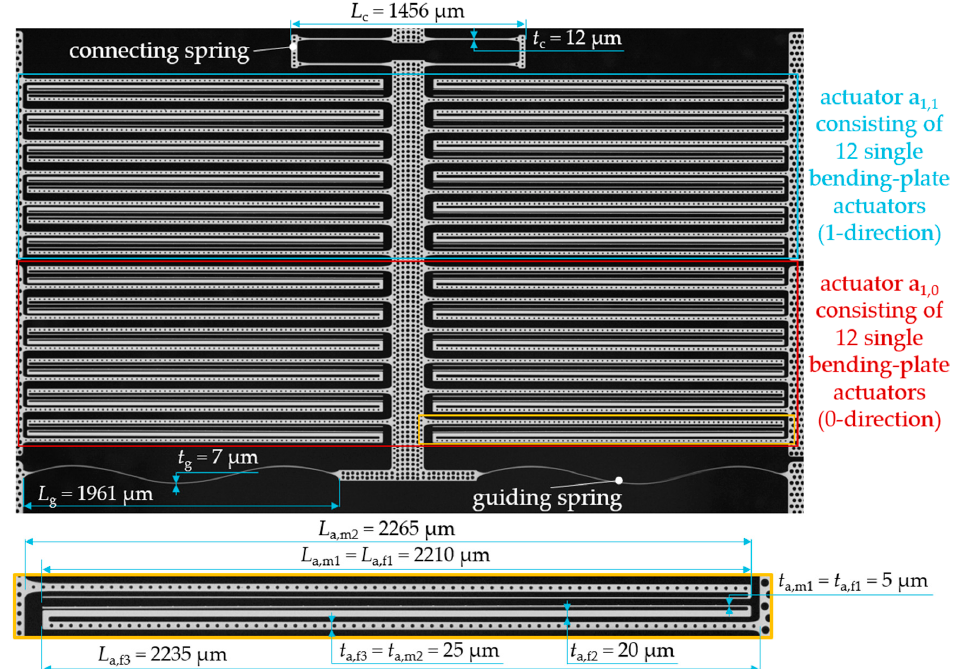
Figure 5. Bit 1 fixed by guiding springs and connected to bit 2 by a connecting spring. Each actuator, a 1,0 and a 1,1 , consists of 12 single bending-plate actuators (stiching microscope image).